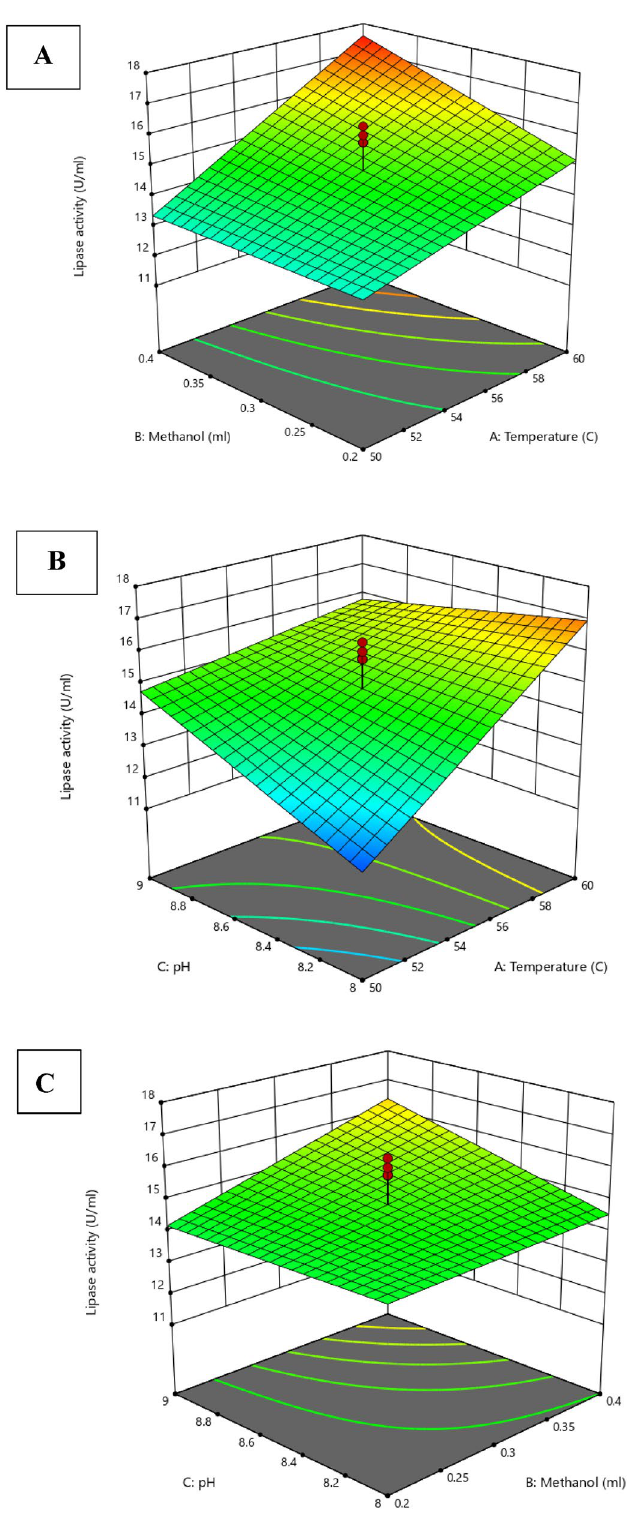
Figure 8. Three-dimensional plots of lipase catalytic activities by Kocuria flava ASU5 (MT919305) display the impacts of reaction mixture conditions: ( A ) interaction of Temperature/Methanol; ( B ) interaction of Temperature/pH; and ( C ) interaction of